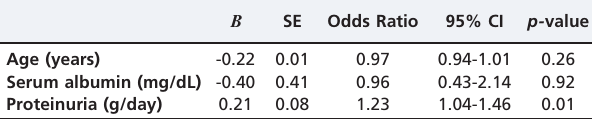
Table 2 - Clinical variables influencing relapse.